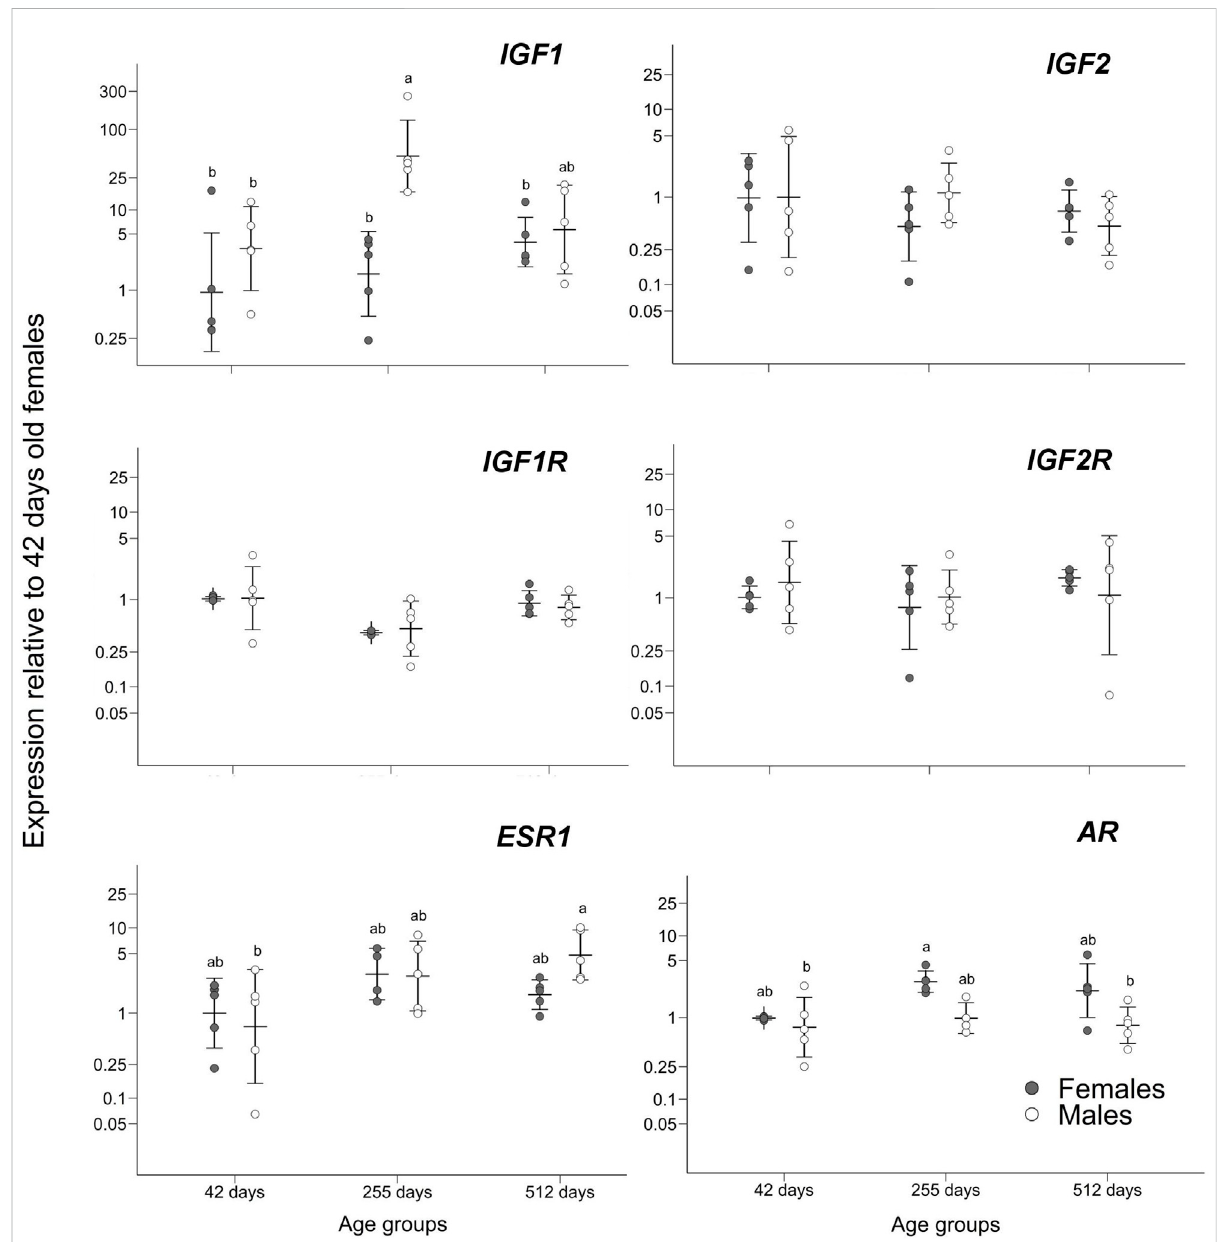
FIGURE 2 Gene expression relative to the group of 42 days old females. Means ± standard deviations are depicted. Statistically homogenous groups as identi fi ed by the post hoc Tukey test are depicted where there were signi fi cant differences among sex/age